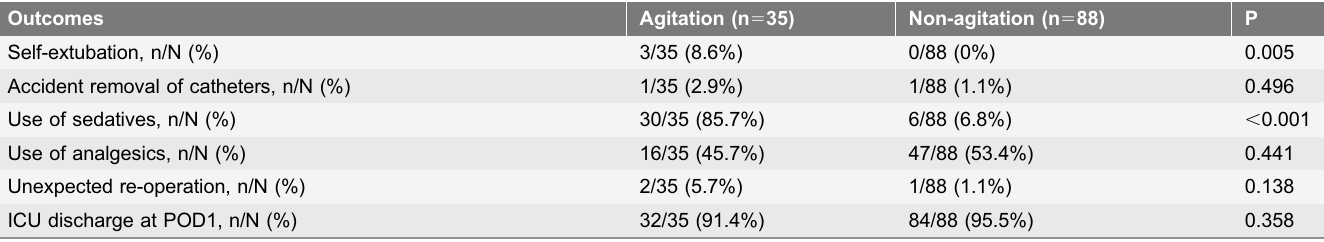
Table 5. Outcome variables in the agitation and non-agitation